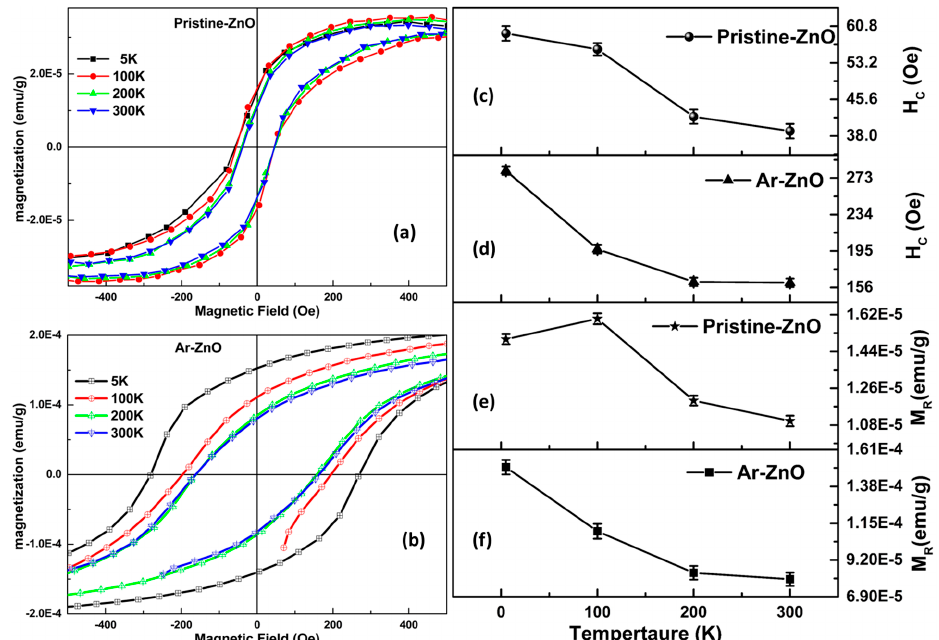
Figure 7. ( a , b ) Magnetization (M) vs. magnetic field (H) hysteresis loops of pristine ZnO and Ar-ZnO nanowires, respectively; ( c – f ) Variation of coercivity (Hc) and remnant magnetization (M R ) with temperature from 5 K–300 K.